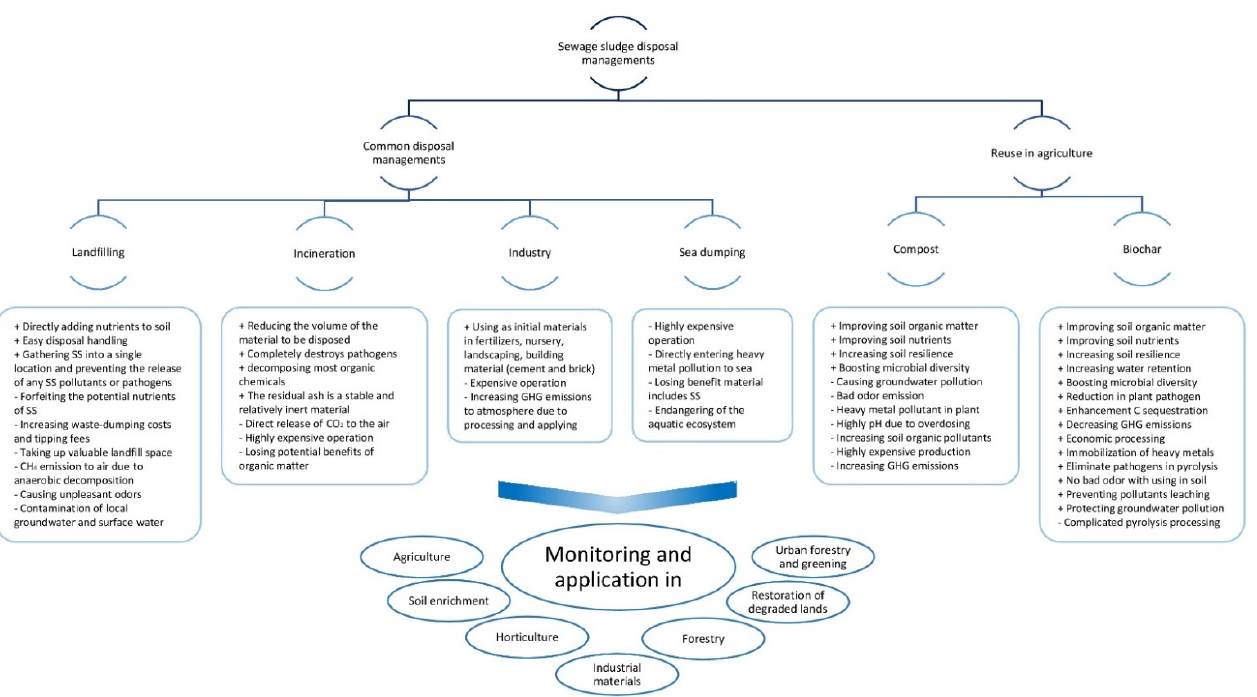
Figure 1. Summary of scope and content of the review focusing on environmental effects of common SS disposal managements compared with reuse in agriculture.